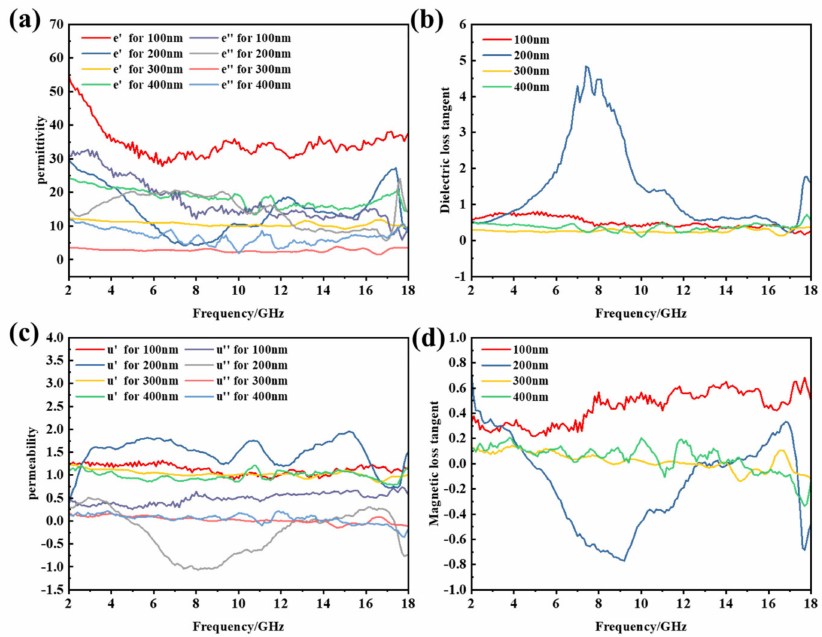
Figure 9. Permittivity and Permeability spectra of Fe 3 O 4 /MWCNT composite materials with dif- ferent size of clusters: ( a ) real part and imaginary part of the permittivity, ( b ) dielectric loss factor, ( c ) real part and imaginary part of the permeability and ( d ) magnetic loss